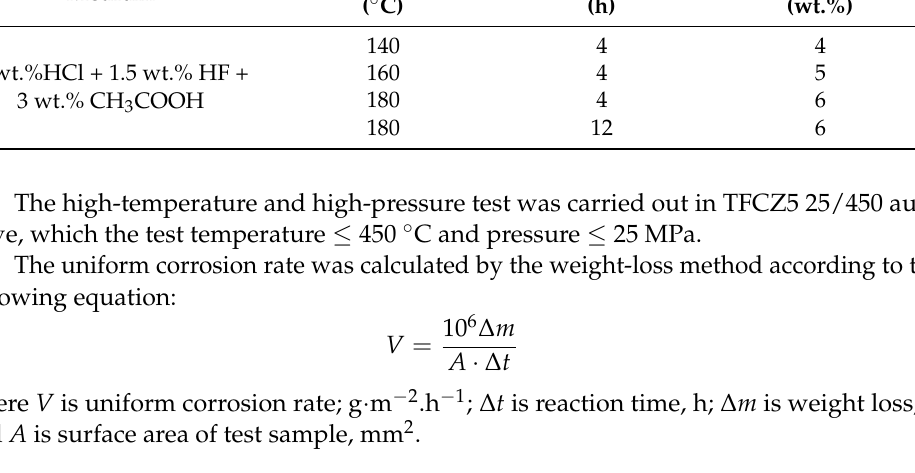
Table 1. The specific corrosion inhibitor test conditions of 2205 duplex stainless steel in ultra-high- temperature acidizing. Medium